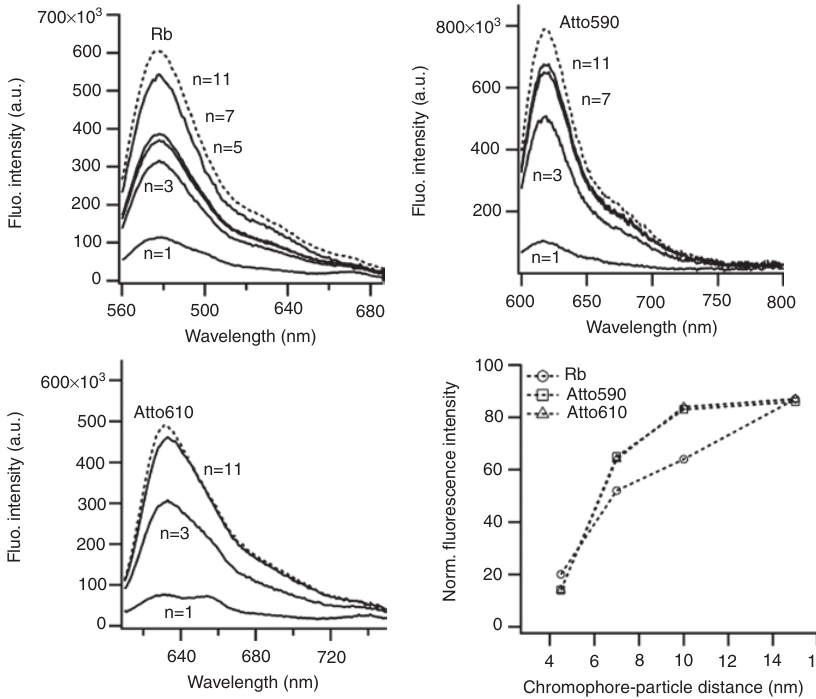
Figure 20: Emission spectrum of hybrid gold nanostars stabilized with several layers of polyelectrolytes. (A) Rhodamine B, (B) Atto590, and (C) Atto610. “n” corresponds to the number of deposited layer. The chromophores were deposited on the ultimate PSS layer of the structure through electrostatic interactions: AuStar(PSS-PDD) of the estimated dye-to-particle distances. Reprinted with permission from Ref. [135]. Copyright (2015) American Chemical